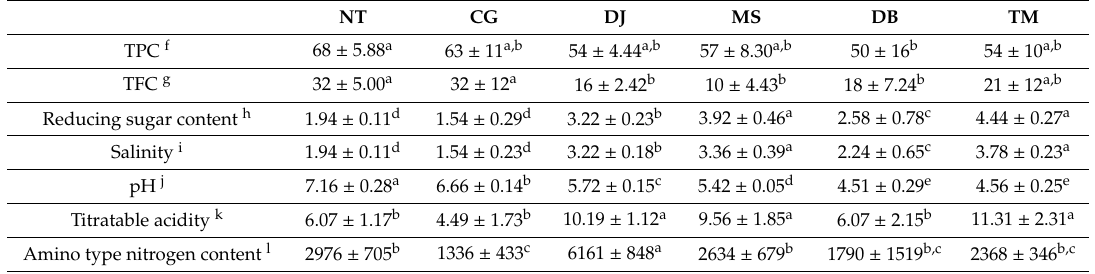
Table 2. Comparison of bioactivity phenotypes and physicochemical characteristics in the six